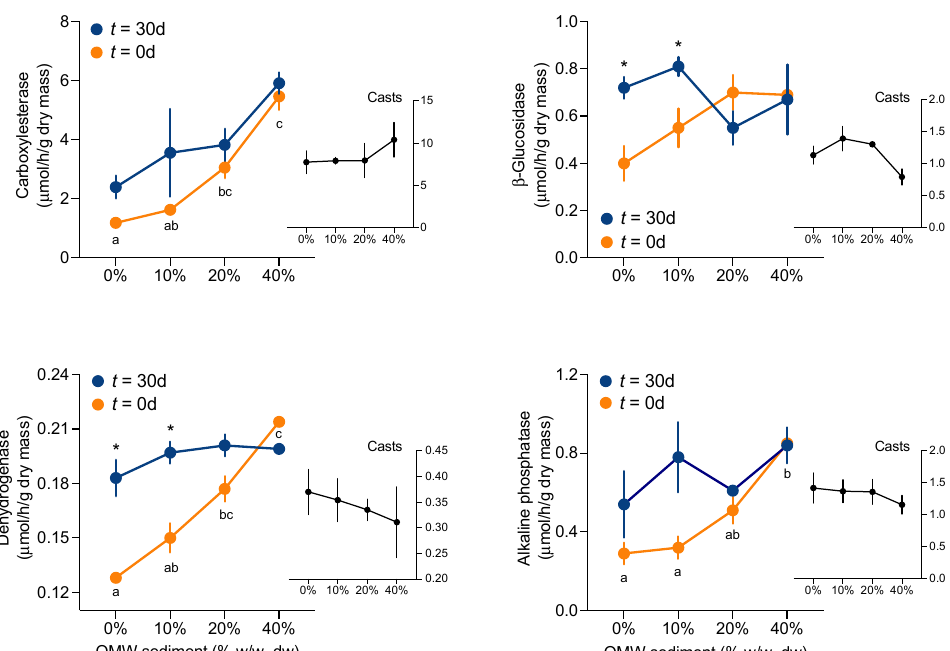
Figure 5. Mean ( ± SEM) enzyme activity in olive mill waste (OMW)-amended soils at t = 0 d and after 30 d of incubation. Different letters indicate significant differences between OMW treatments ( p < 0.05, Welch’s t post-hoc test), whereas asterisks denote differences between soils inoculated with earthworms and earthworm-free ( p < 0.05). Inset plots show the mean (± SEM) enzyme activity in casts collected from the soil surface after 30 d of incubation.